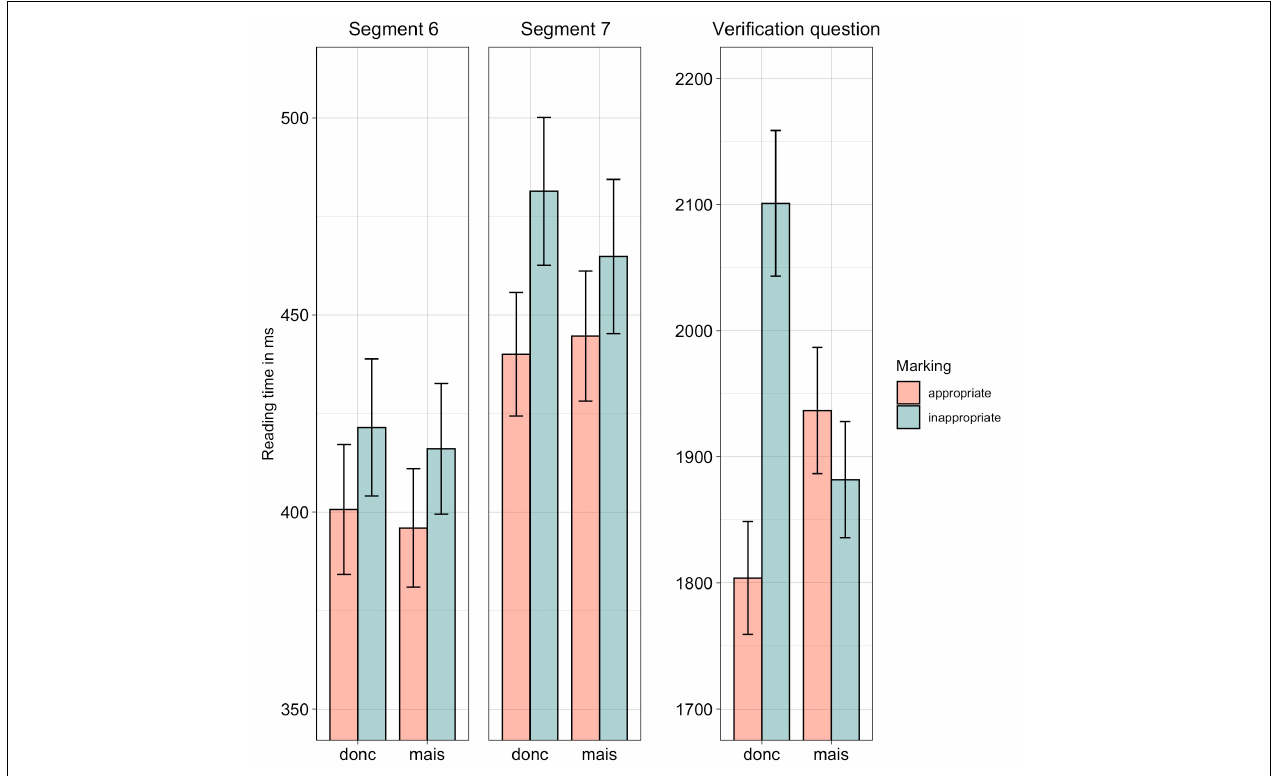
FIGURE 1 | Experiment 1, reading times for Segments 6 and 7 as well as response times to the verification question. CI of 95% as error